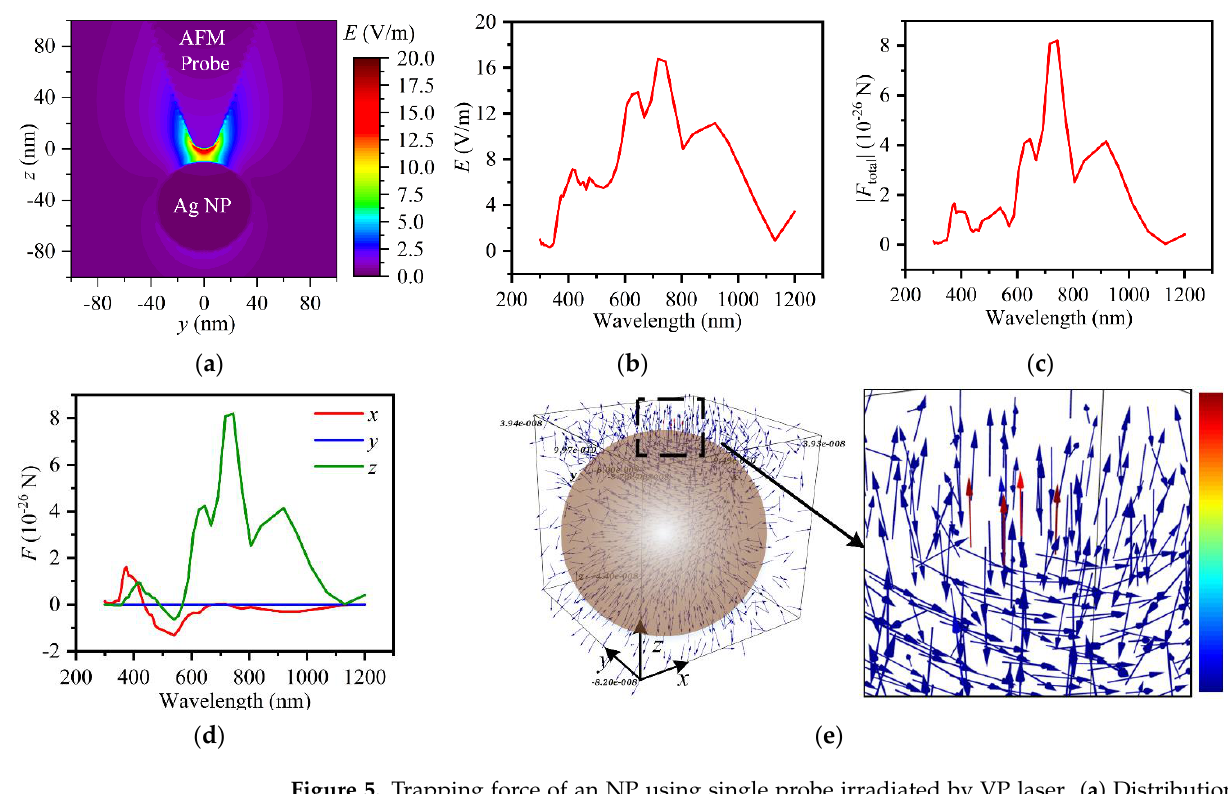
Figure 5. Trapping force of an NP using single probe irradiated by VP laser. ( a ) Distributions of electric field in y-z plane; ( b ) Electric intensities at the end of probe tip versus wavelength of incident laser; Total optical force ( c ) and component forces along x , y , z axis ( d ) applied on the NP versus wavelength of incident laser; ( e ) Distributions of optical forces per unit volume in vector form for wavelength 717 nm.